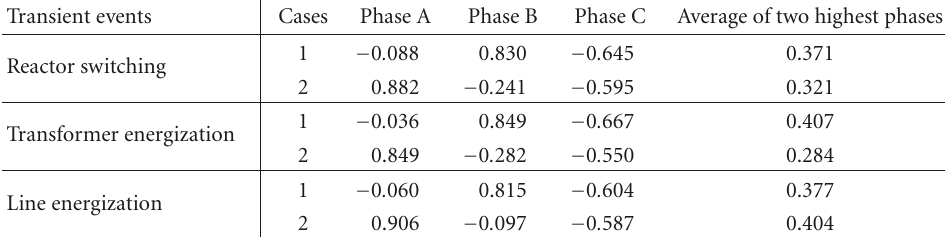
Table 5: Results of other